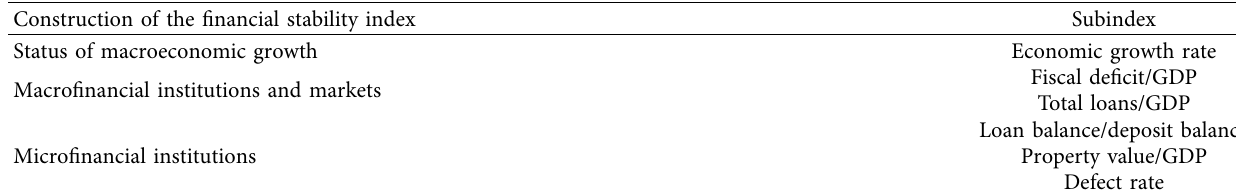
Table 7: Construction of the financial stability